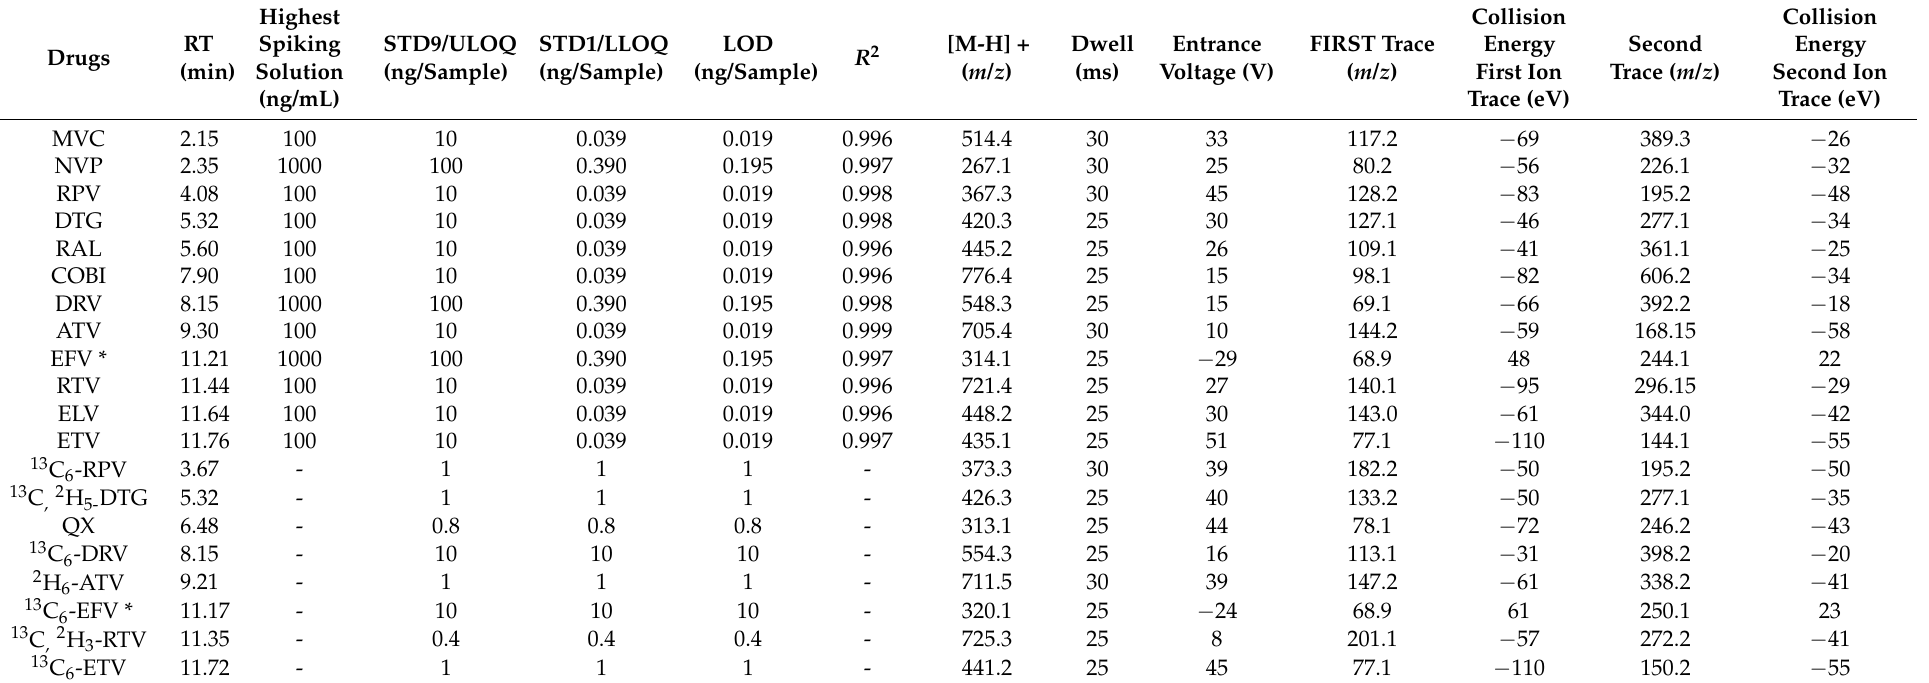
Table 1. For each compound are reported, in order: mean retention time (RT), highest spiking solution concentration, final drug amounts in the standard (STD) 9 to STD1/LLOQ, LOD, dwell times and mass transitions (parent ions, first and second daughter ions), with the corresponding cone voltages and collision energies. Unit “ng/sample” refers to the absolute amount of drug added to a blank PBMC aliquot of 16 × 10 6 cells, to obtain the calibration STDs. LLOQ: lowest limit of